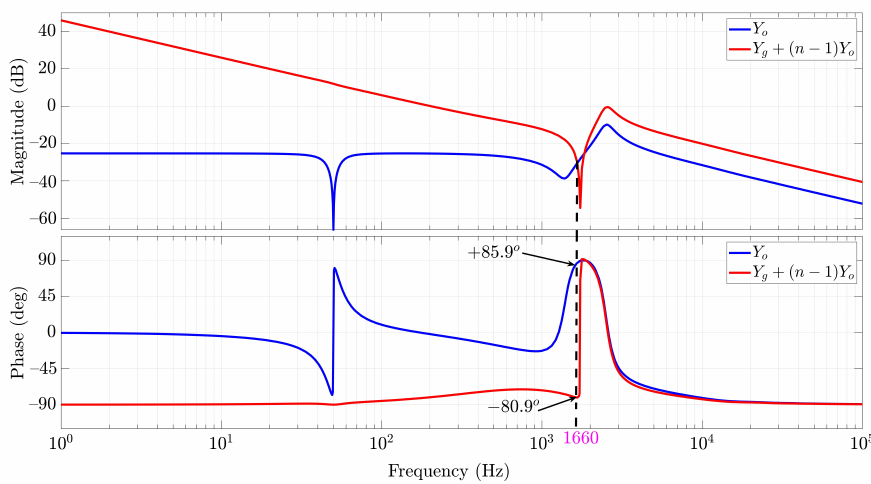
Figure 15. Bode plot of admittances of four identical parallel VSIs connected to the grid.